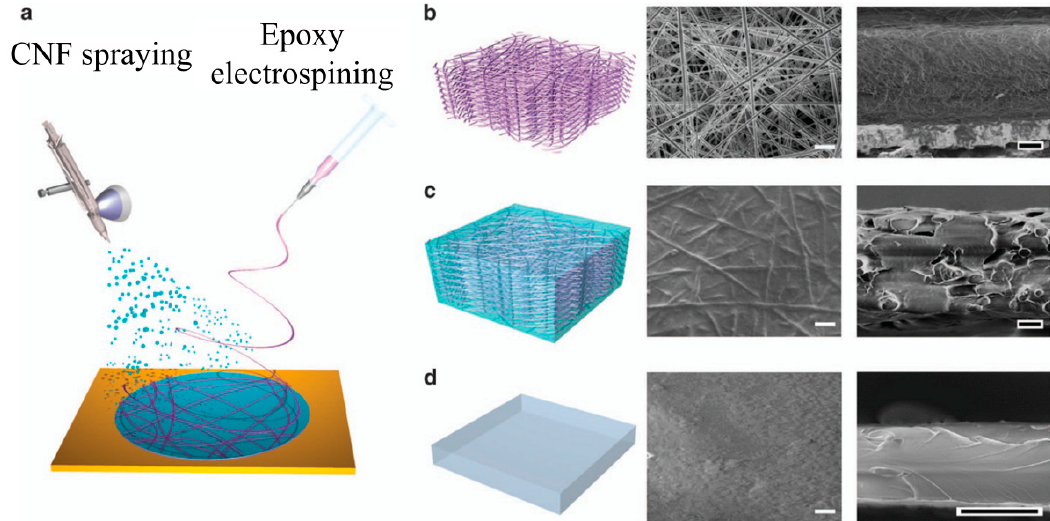
Figure 8. Preparation of the cellulose nanofibers (CNF) hybrid film. ( a ) A schematic image of an electrospinning epoxy backbone and spraying CNF fillers simultaneously. Schematics and scanning electron microscopy (SEM) images (top and cross-sectional views) of ( b ) the electrospun three-dimensional (3D) epoxy nanoweb structure, ( c ) the CNF epoxy hybrid before hot pressing, and ( d ) the CNF–epoxy hybrid after hot pressing. White scale bars are 10 μ m, and black scale bars are 20 μ m. (Adapted from [92] ).